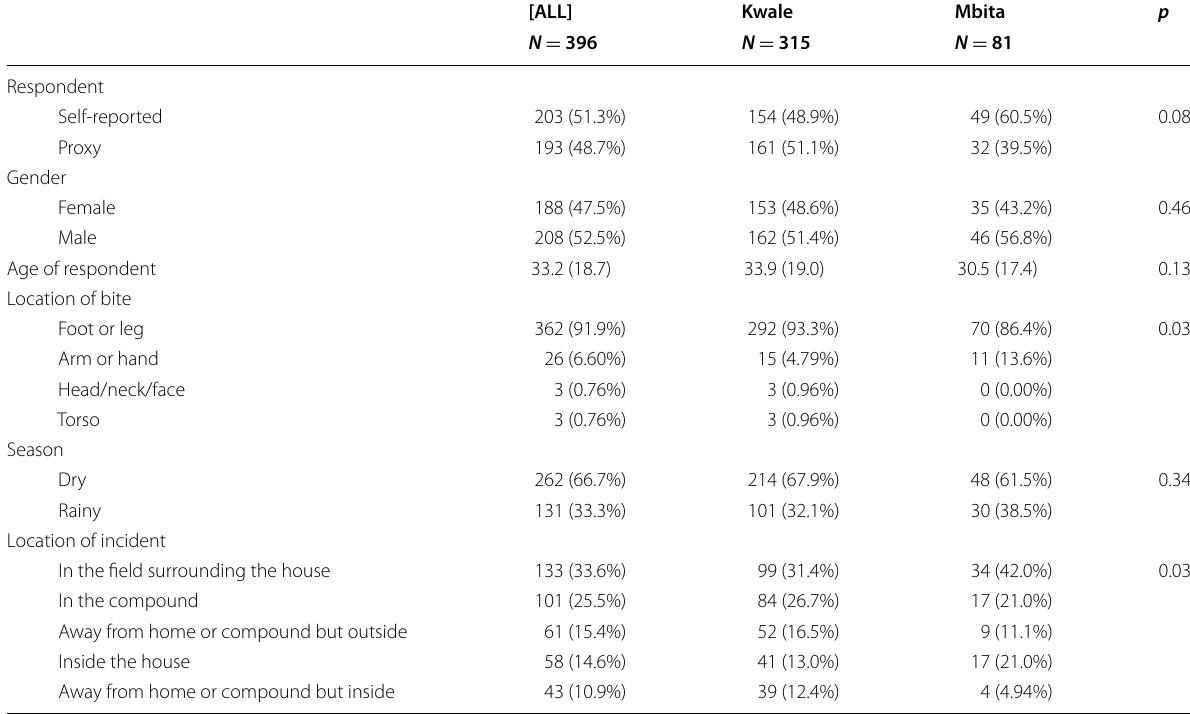
p -values represent Chi-square tests for independence between region with categorical variables and T -tests for the continuous measure of